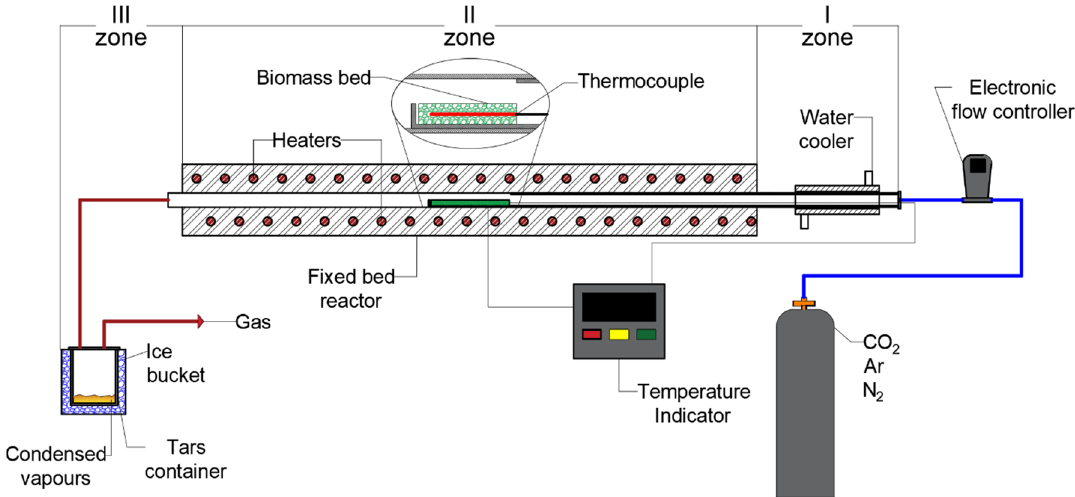
Figure 1. Experimental setup for the intermediate pyrolysis